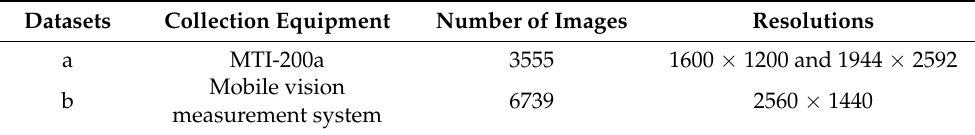
Table 2. The details of the experimental